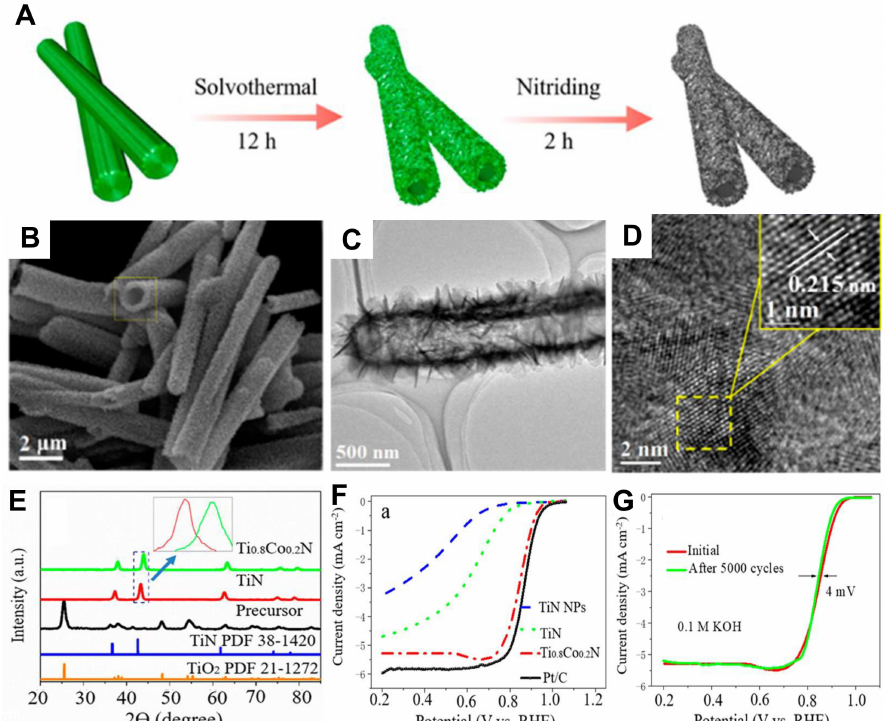
Figure 4. ( A ) Schematic of the formation of titanium nitrides assemblies. ( B ) SEM image of Ti 0 . 8 Co 0 . 2 N assemblies. ( C – D ) TEM images of Ti 0 . 8 Co 0 . 2 N assemblies. ( E ) XRD pattern of TiO 2 , TiN and Ti 0 . 8 Co 0 . 2 N assemblies. ( F ) LSV curves of different electrocatalysts in 0.1 M KOH electrolyte. ( G ) Potential cycling performance of Ti 0 . 8 Co 0 . 2 N assemblies. Reproduced with permission from [74]. Copyright © 2018 American Chemical Society. Table 1. OER electrocatalytic performance of recent advanced TMNs electrocatalysts.